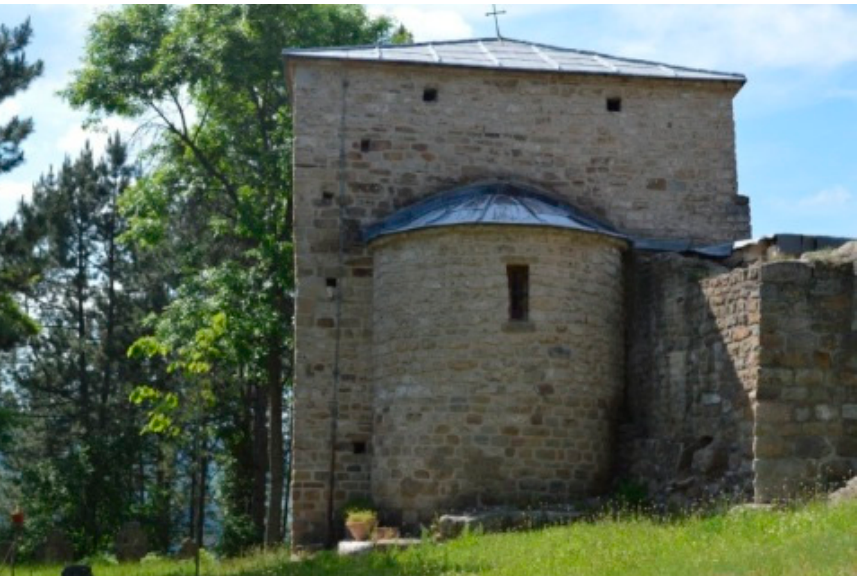
Figure 6. Entrance tower of Monastery of Đ ur đ evi Stupovi turned into the tomb chapel of King Dragutin, around 1282. Photo Č edomila Marinkovi ć .